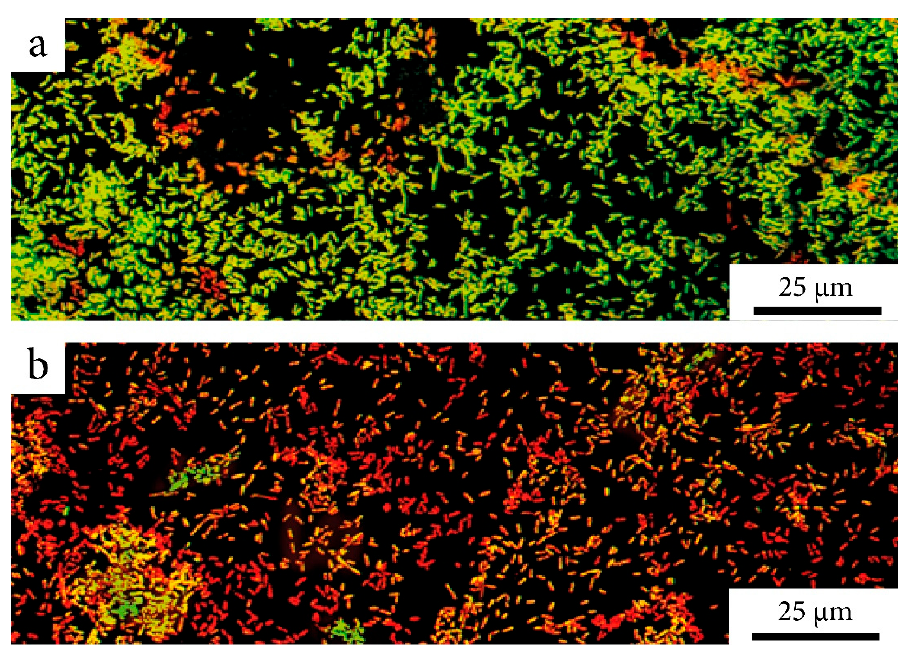
Figure 7. LIVE/DEAD staining of E. coli biofilms after treatment with ciprofloxacin 0.15 µg/mL: ( a ) in its original form; ( b ) immobilized into a nanocomposite. Confocal microscopy. Pseudocolors: red-dead cells and green-living cells.